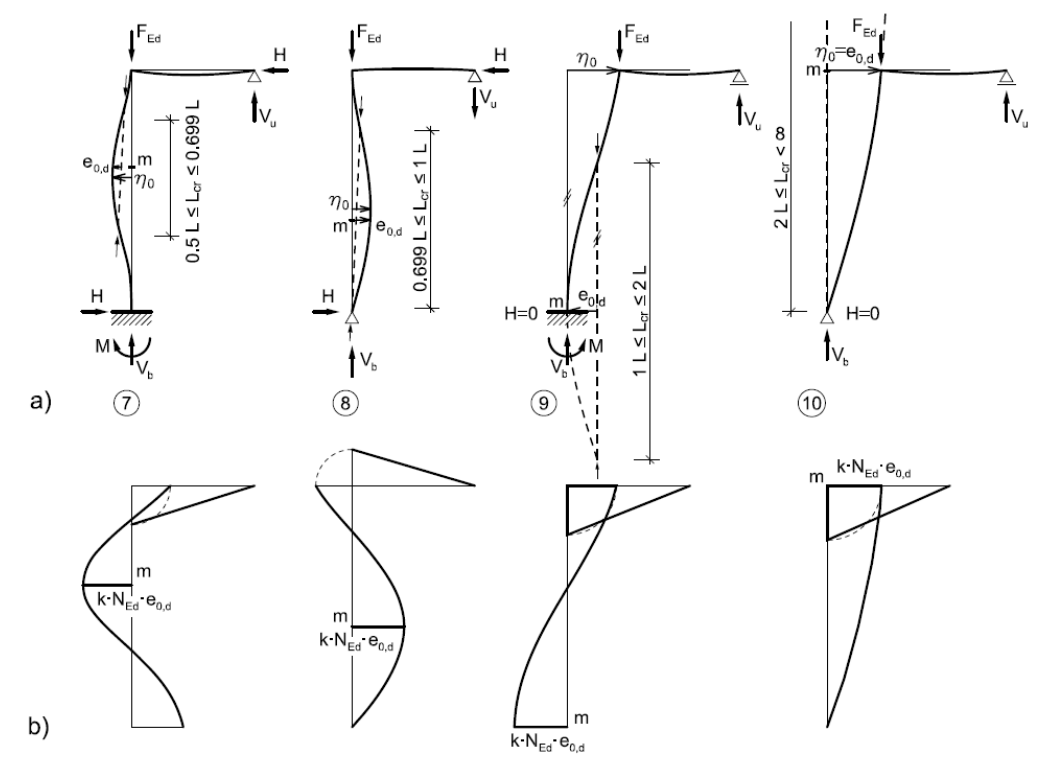
Figure 16. ( a ) UGLI imperfection and locations of 𝑒 (cid:2868),(cid:2914) and 𝜂 (cid:2868) ; ( b ) bending moment distributions and locations of maximum moment 𝑀 (cid:2889)(cid:2914)(cid:2893)(cid:2893) = 𝑘𝑀 (cid:2889)(cid:2914)(cid:2893) = 𝑘𝑁 (cid:2889)(cid:2914) 𝑒 (cid:2868),(cid:2914) in critical point m for cases No.7–No.10.